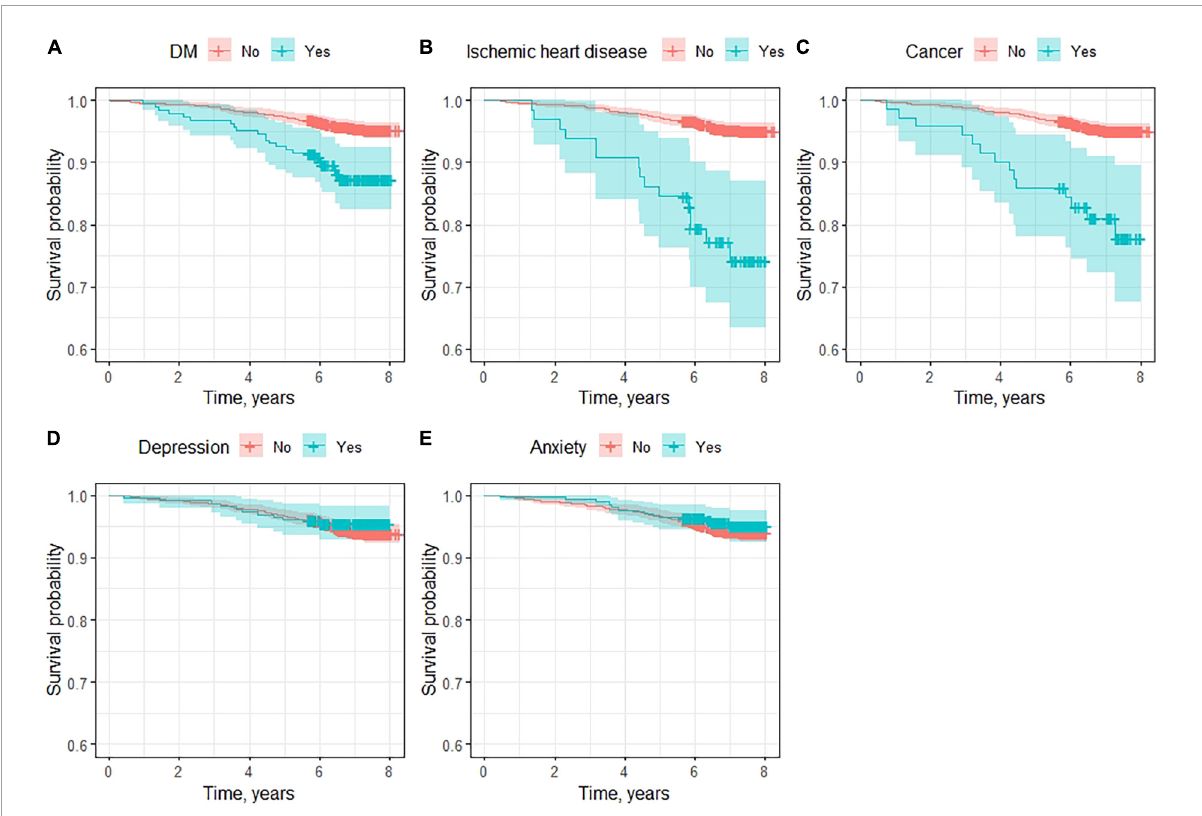
FIGURE3 Survival curves for main comorbidities. (A) Diabetes mellitus, (B) ischemic heart disease, (C) cancer, (D) depression, and (E)